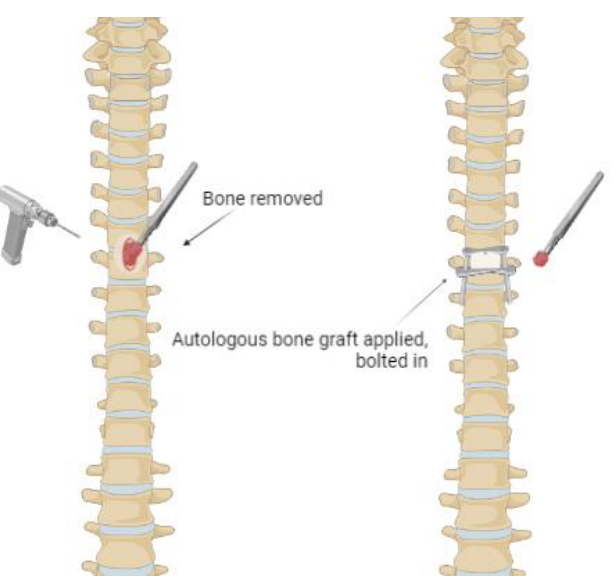
Figure 3. Autogenous bone graft from a primary benign tumor in the